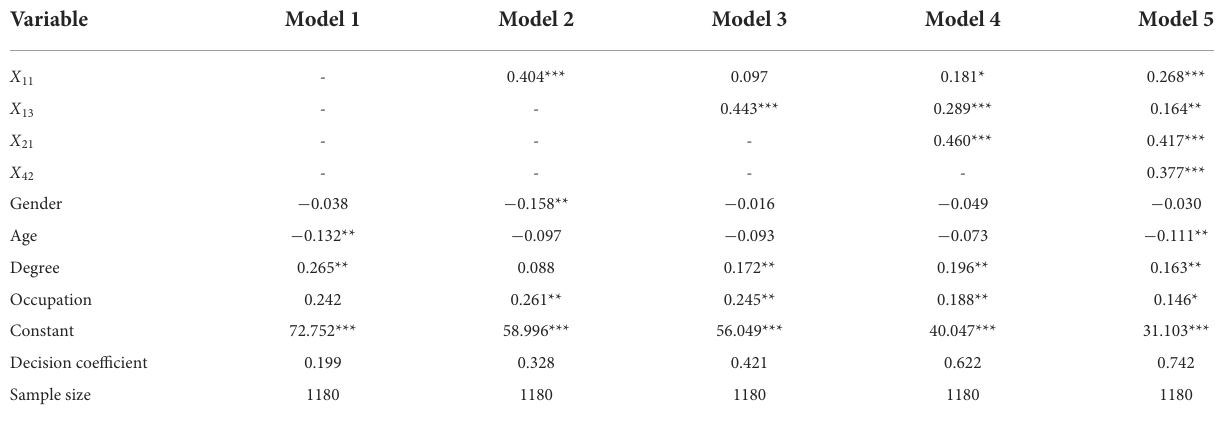
TABLE 8 Multiple regression